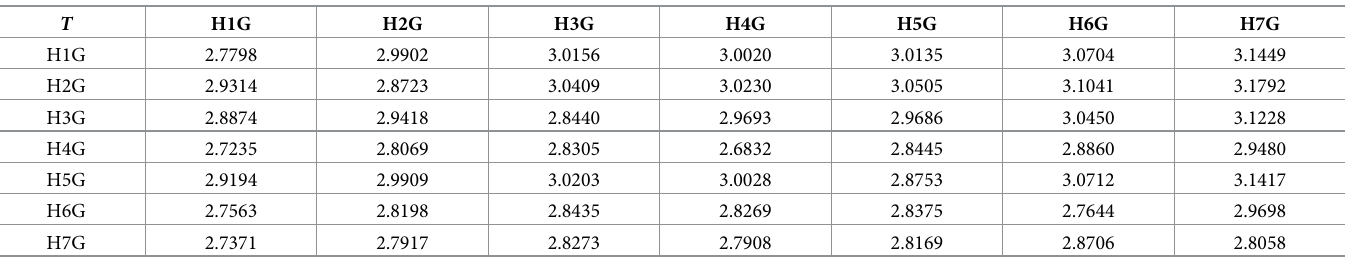
Table 4. The total-relation matrix.